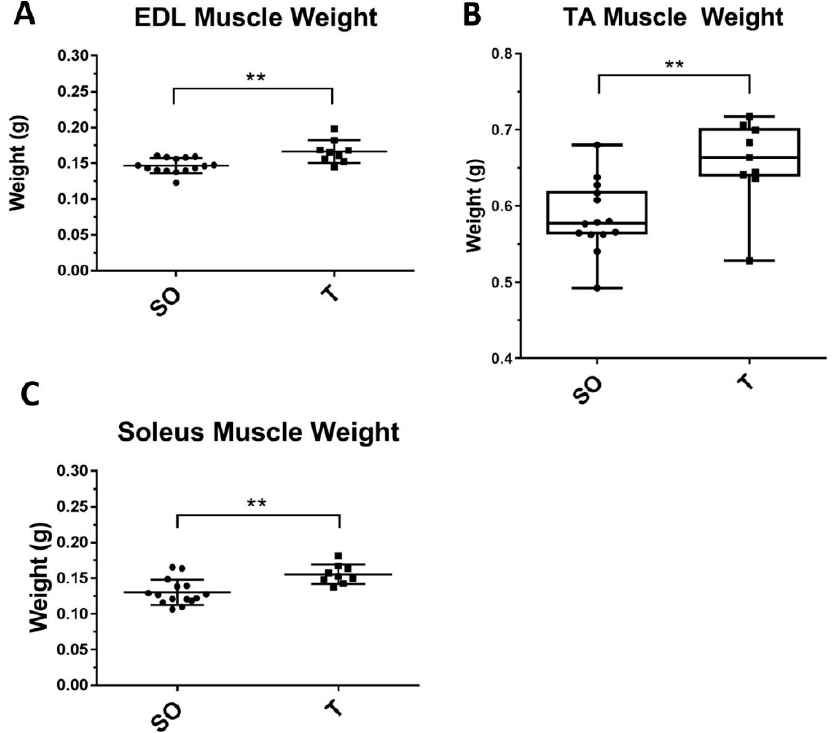
Figure 3. Greater hindlimb skeletal muscle mass in PNA rats compared to control rats. At 16 weeks of age, animals were euthanized and hindlimb muscles were carefully dissected from female rats prenatally exposed to sesame oil (SO, n = 15) or testosterone (T, n = 9) prior to weighing. Data with normal distribution were analyzed by unpaired t-tests ( A , B ), and those not normally distributed were analyzed by Mann–Whitney U test ( C ). Values are means ± SD ( A , B ) or quartiles with the median shown ( C ). ** p <